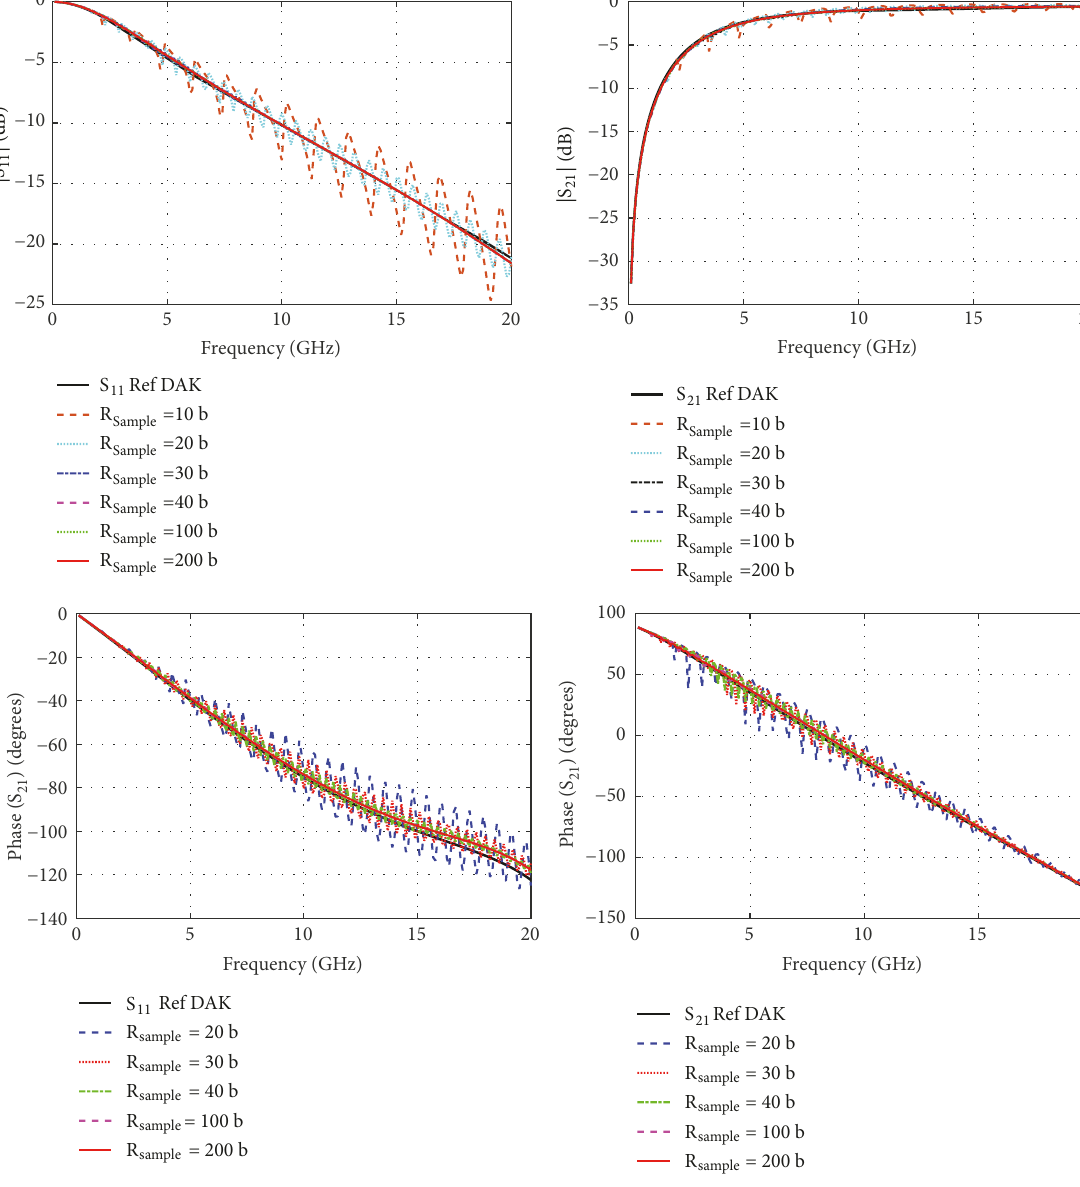
modes at the input/output coaxial lines, for n